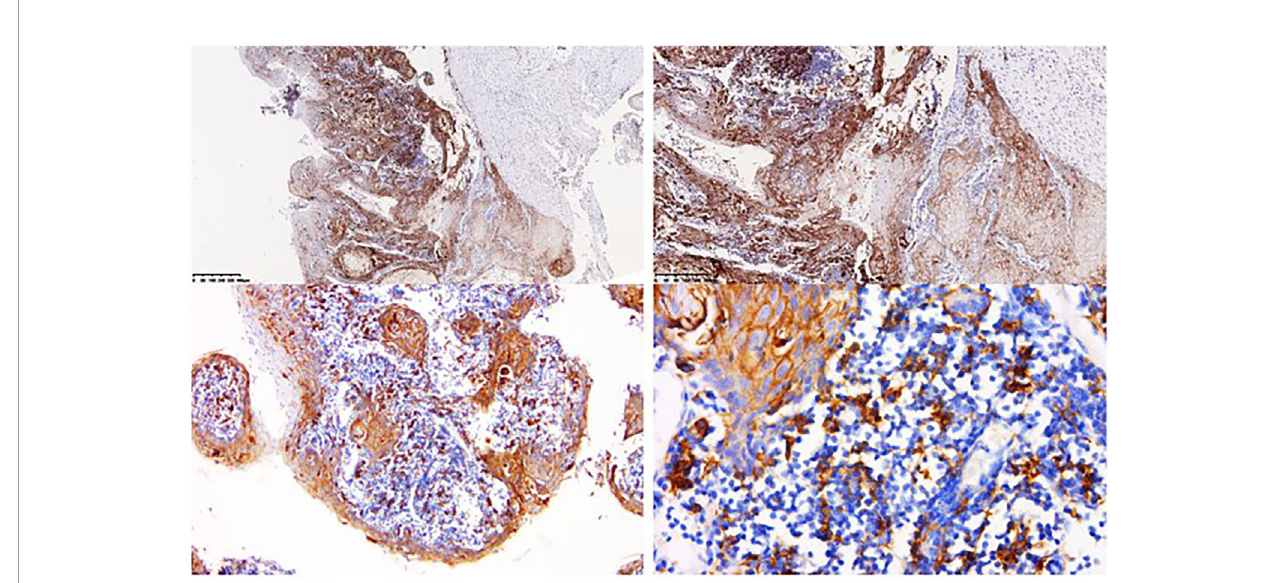
FIGURE 2 | Immunohistochemical testing of tissue from the fi rst biopsy. Immunohistochemical testing of tissue from the fi rst biopsy reported strong membranous staining of PD-L1 in more than 90% of tumor cells and 25% of tumor associated immune